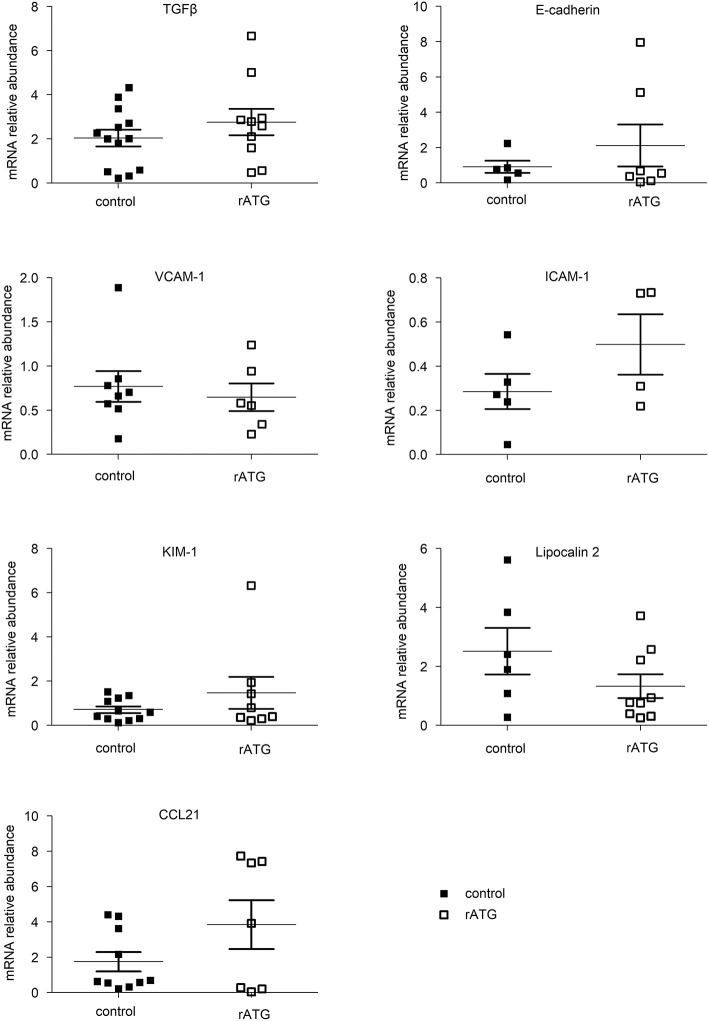
mRNA analysis of candidate genes in kidney biopsies taken 1 h post-reperfusion. Data from available tissue specimens are shown. mRNA measurement of selected candidate genes indicative for inflammation and adhesion did not reveal significant differences between ATLG-perfused kidneys and control kidneys. ATLG: open boxes, control: filled boxes. Data are presented as mean ± SEM.